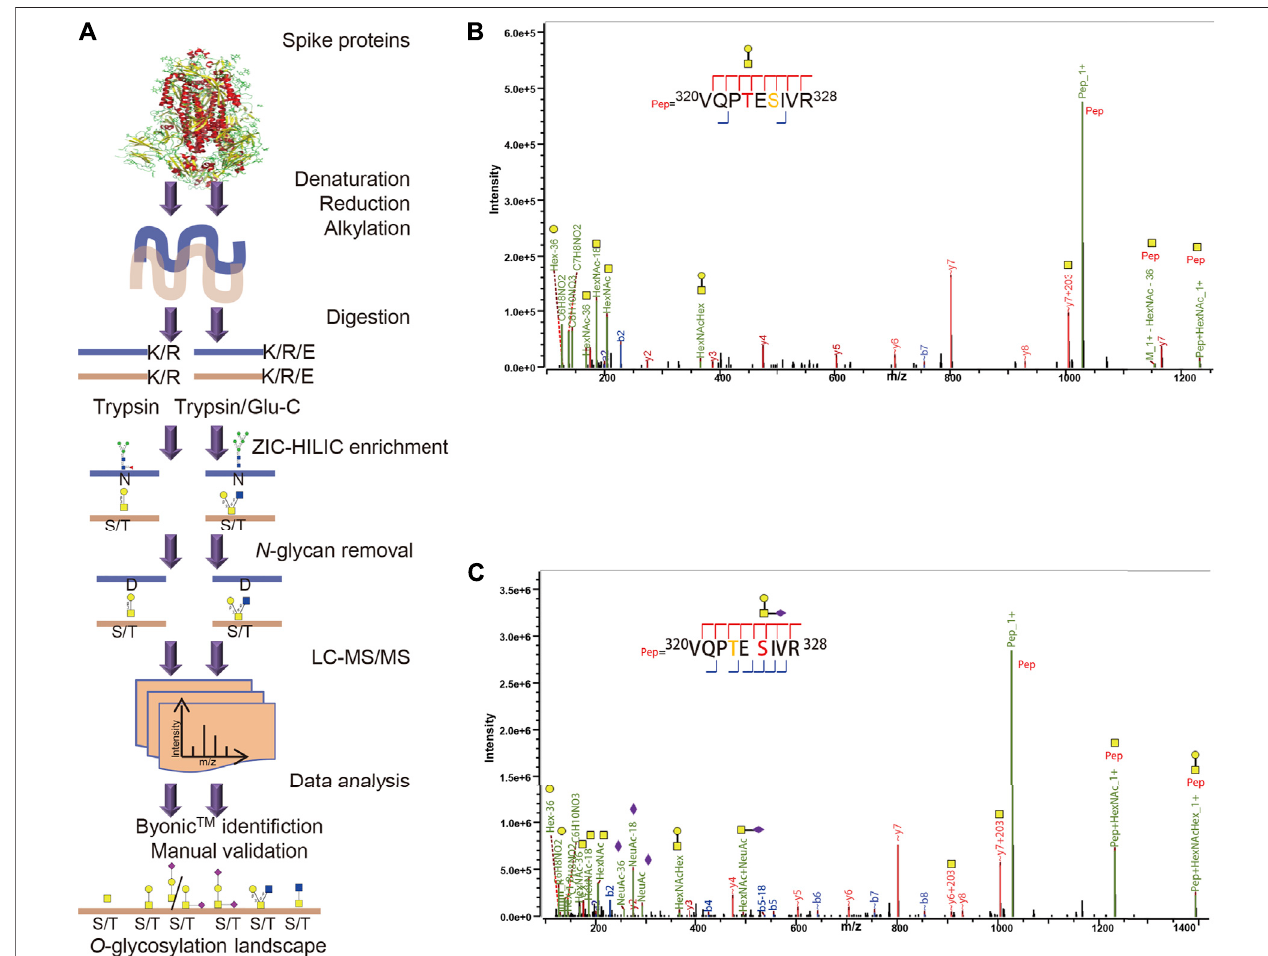
FIGURE 1 | Comprehensive O -glycosylation pro fi ling of SARS-CoV-2 spike proteins. (A) SARS-CoV-2 spike proteins expressed in insect or human cells were digested using trypsin or a mixture of trypsin and Glu-C. After ZIC-HILIC enrichment and PNGase F digestion, intact O -glycopeptides were analyzed using a high- resolution mass spectrometer, and their spectra were characterized using Byonic ™ software and validated manually. (B) HCD-MS/MS spectrum of reported representative O -glycopeptide 320 VQPTESIVR 328 with deduced GalNAcGalglycan detected on site Thr323 or Ser325 ofhuman spike protein subunit 1. (C) HCD- MS/MS spectrum of this O -glycopeptide with deduced GalNAcGalNeuAc glycan detected on site Thr323 or Ser325.